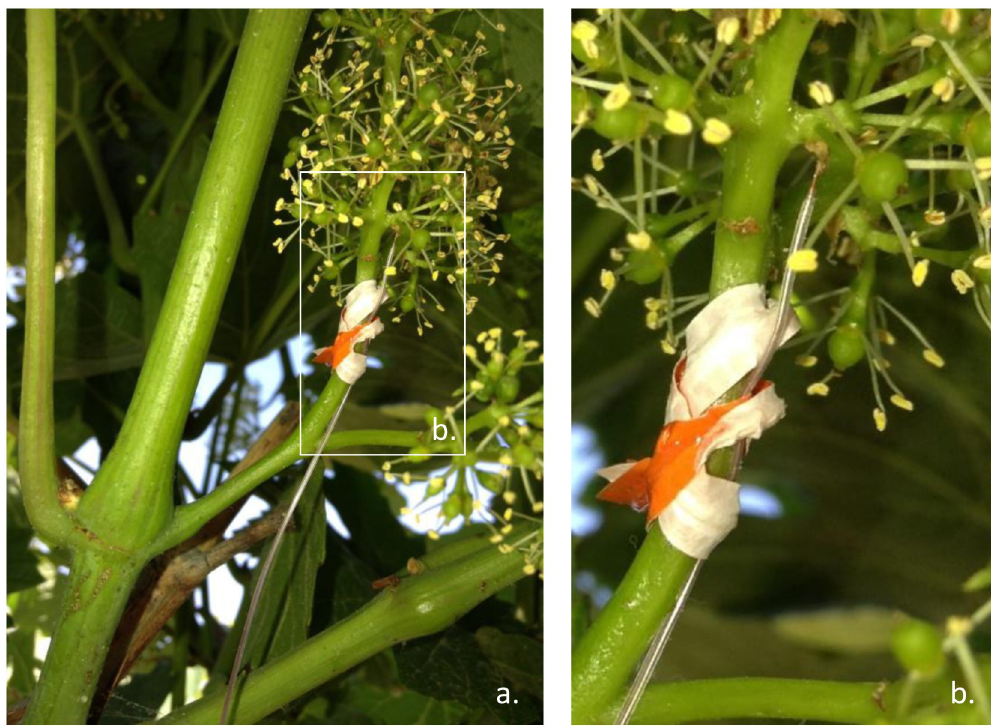
Fig 2. Probe installed to measure air temperature within berry clusters (a). “T type” thermocouples were installed in the rachis, close to the first or second branching point